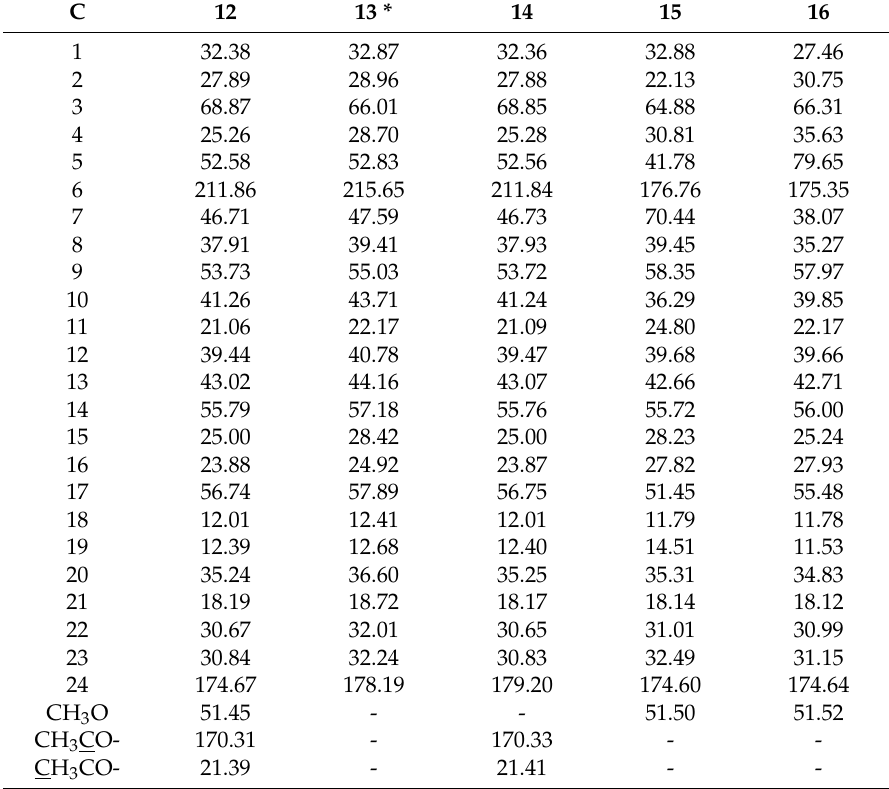
Table 1. Chemical shifts, δ , of 13 C-NMR (CDCl 3 , 100.6 MHz) for compounds 12 – 16